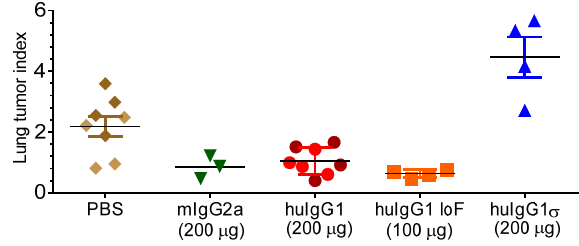
Figure 9. Effect of silent Fc mutations on syngeneic tumor cell metastasis. Fc γ R ‐ humanized mice were injected IV with B16F10 cells and received either: phosphate ‐ buffered saline (PBS), Ab5 (TA99) mIgG2a, Ab5 huIgG1, Ab5 huIgG1 LoF (low fucose) or Ab5 huIgG1 σ ( n = 4 for groups) on days 0, 2, 4, 7, 9 and 11. On day 21, lungs were harvested and metastasis foci were counted. Data show the mean number of lung metastasis foci expressed as lung tumor index from mice receiving the indicated treatment ± standard